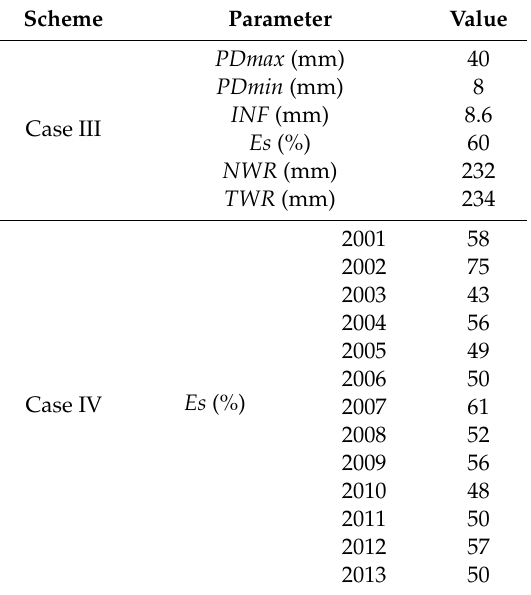
Table 4. Calibrated parameter values for Case III and Case